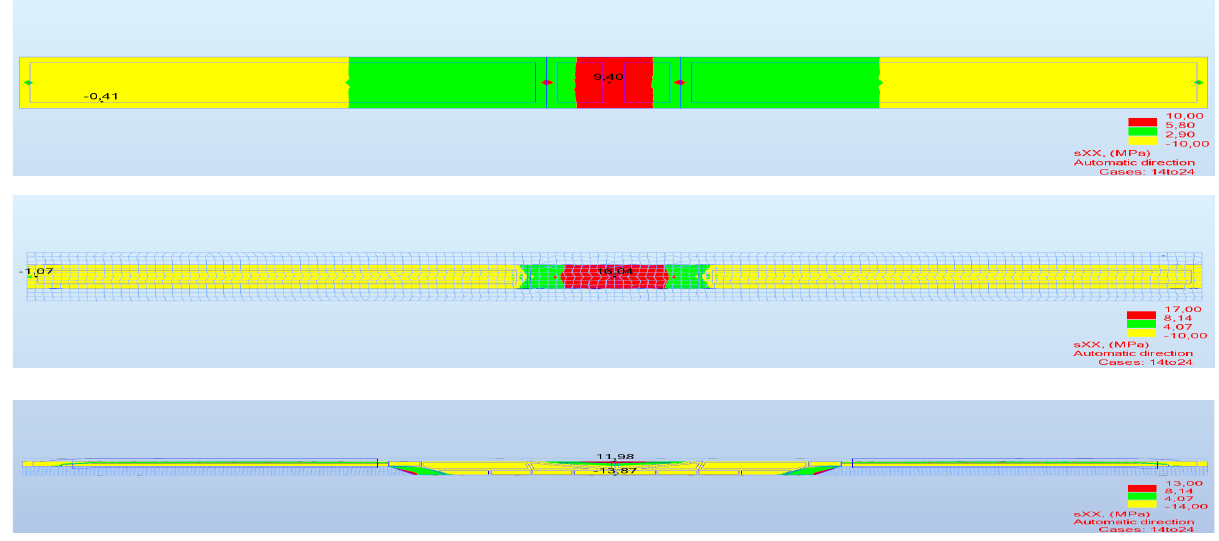
Figure 16: Tensile stress layout in in situ slab (top view), upper slab (top view) and concrete web of the prefab (side view) – cracked analysis (step 2).